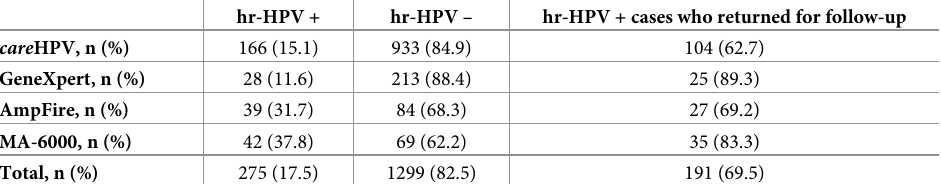
Table 3. Distributions of hr-HPV test results and follow-up rates following standalone hr-HPV testing stratified by